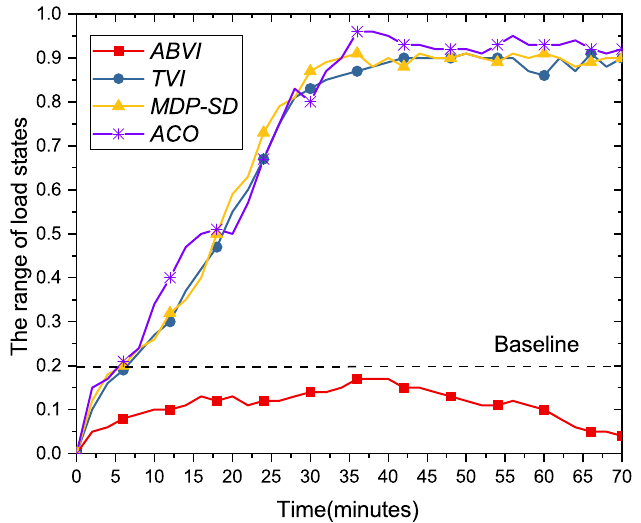
Figure 9. The comparison of the ABVI algorithm and the other two algorithms in optimizing the load of the UAV